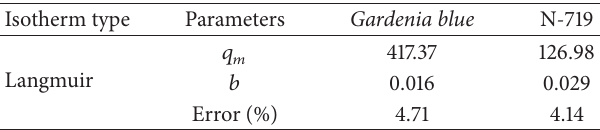
Table 1: Langmuir isotherm constants of Gardenia blue and N-719 on TiO thin 2